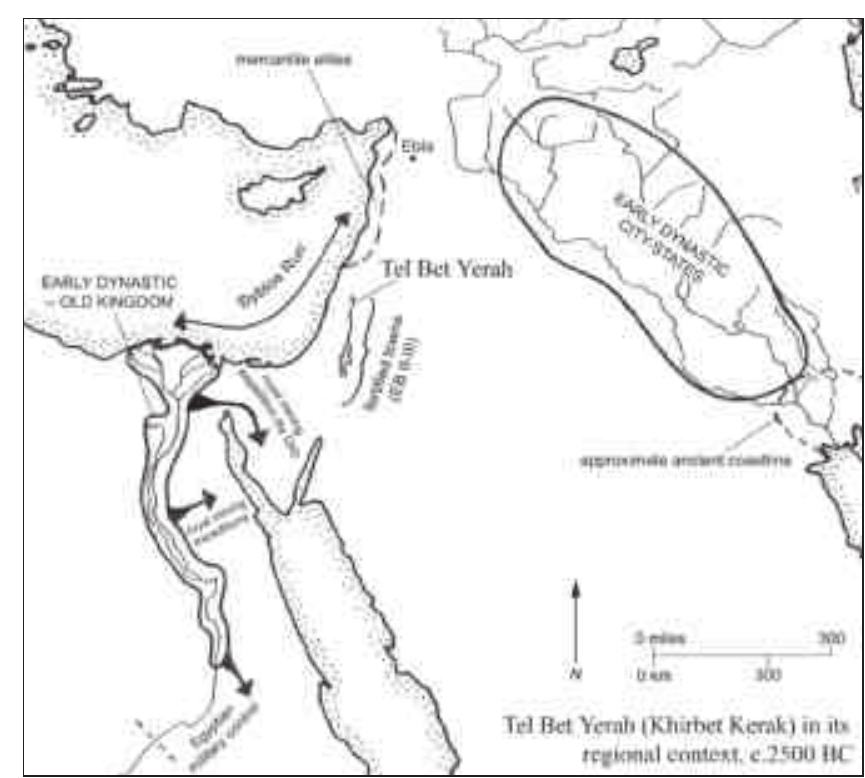
Figure 2 Early Bronze Age Tel Bet Yerah in its interregional